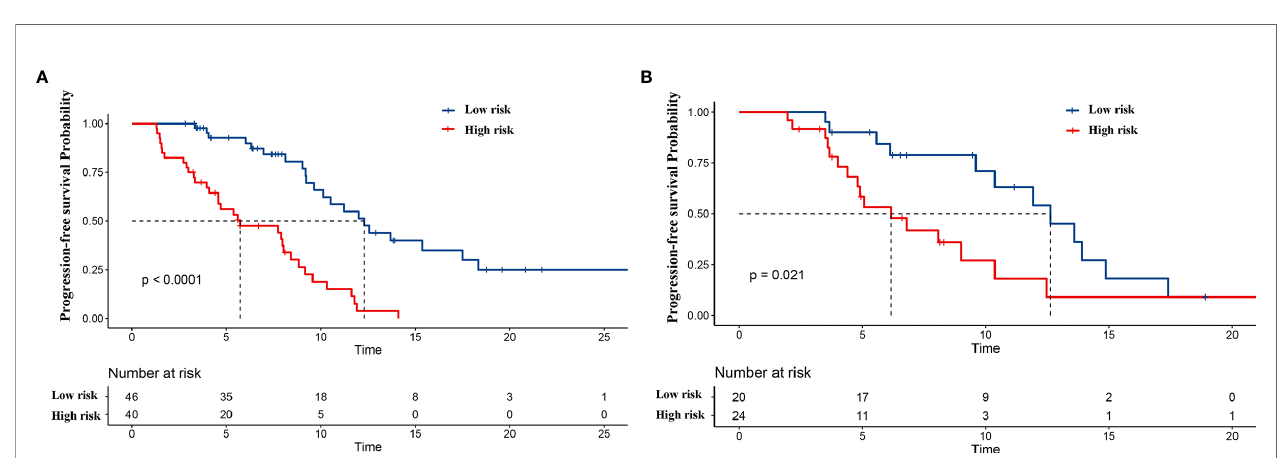
FIGURE 6 | Kaplan – Meier curves for two subgroups according to the cutoff value in the training cohort of the nomogram-based total score. The blue curve and red curve represent the low-risk (0 – 100) and high-risk (>100) groups, respectively. Kaplan – Meier curves for progression-free survival (PFS) in (A) the training cohort and (B) validation cohort.